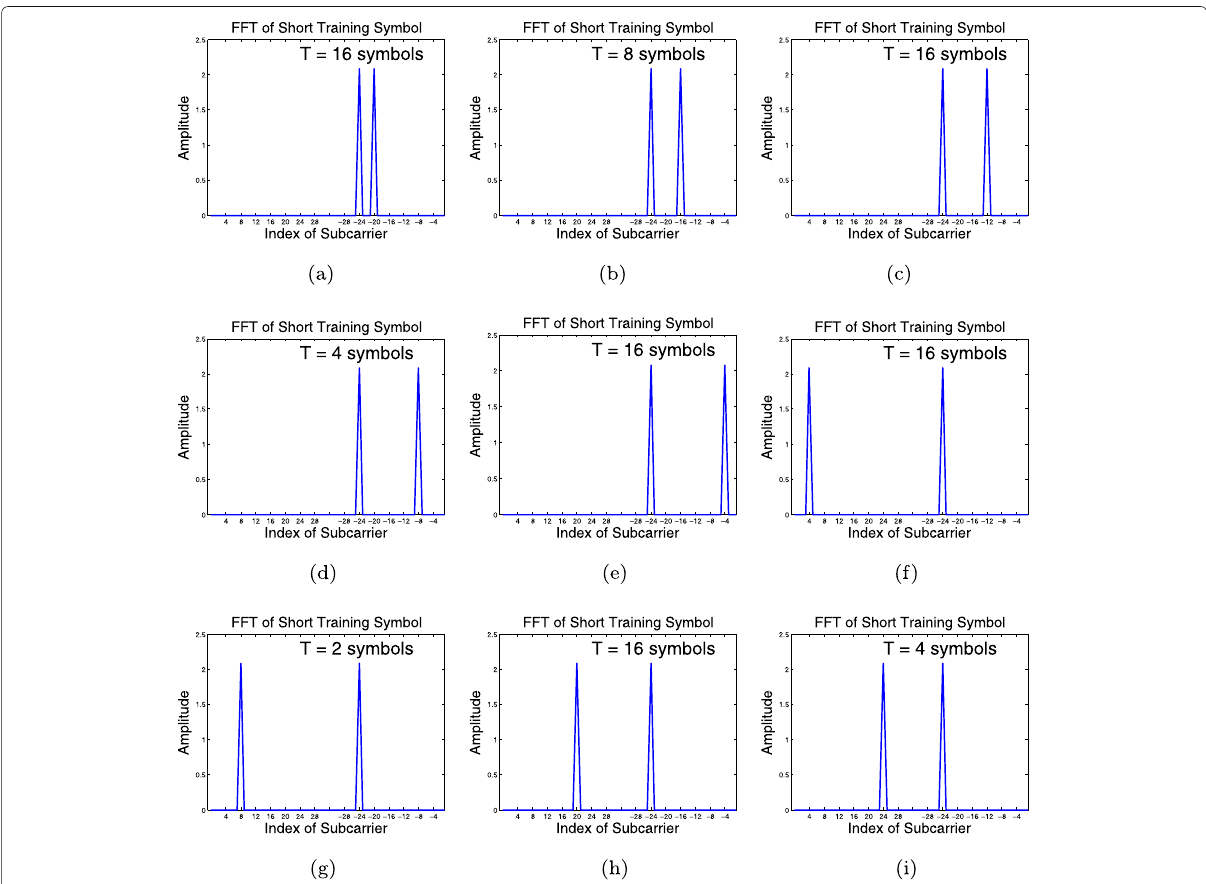
Fig. 5 Observation 1: the period of STS is determined by subcarrier frequency spacing (cid:3) F . a (cid:3) F = 4 (cid:3) f , b (cid:3) F = 8 (cid:3) f , c (cid:3) F = 12 (cid:3) f , d (cid:3) F = 16 (cid:3) f , e = 20 (cid:3) (cid:3) = 24 (cid:3) (cid:3) = 28 (cid:3) (cid:3) = 40 (cid:3) (cid:3) = 44 (cid:3) (cid:3) F F F F F f , f f , g f , h f , i